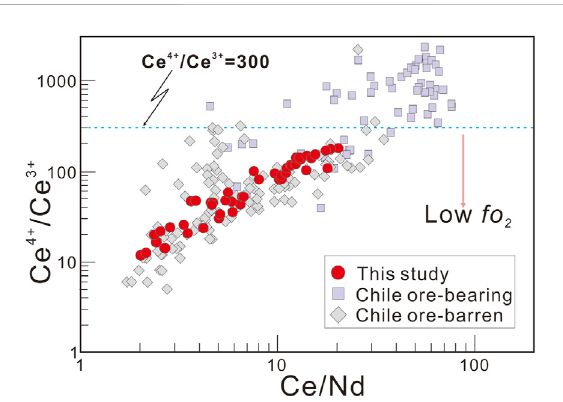
FIGURE 11 Ce/Nd vs. Ce 4+ /Ce 3+ ratios diagram (ore-bearing and